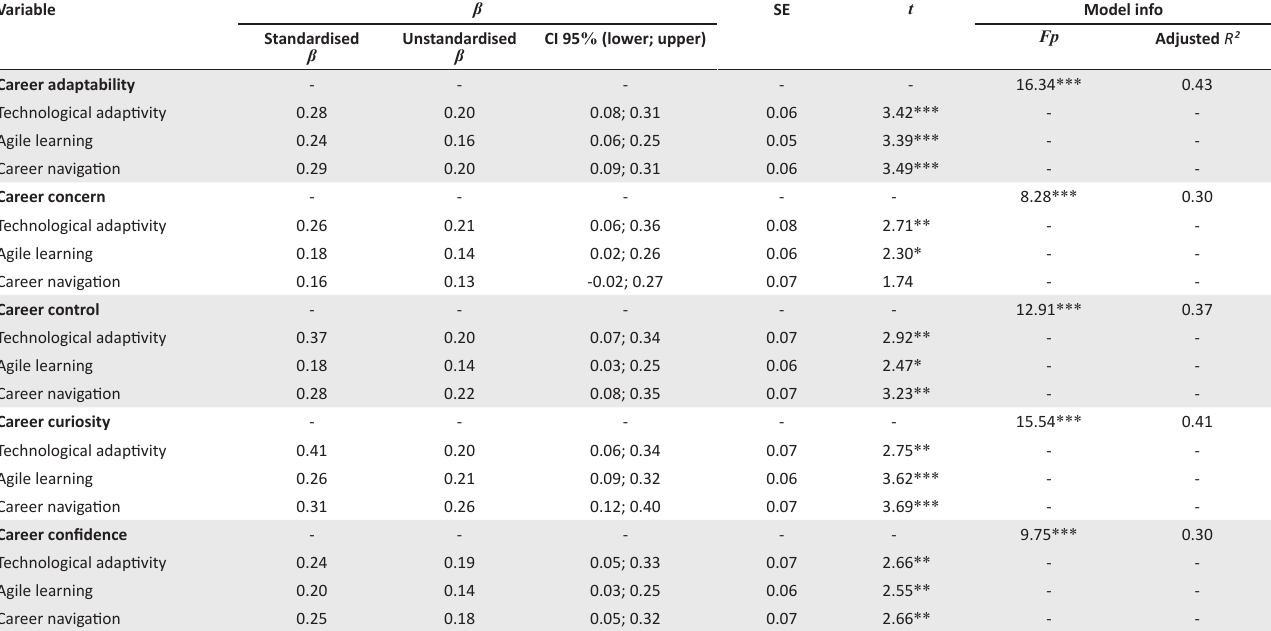
TABLE 2: Results of multiple regression analysis ( N =